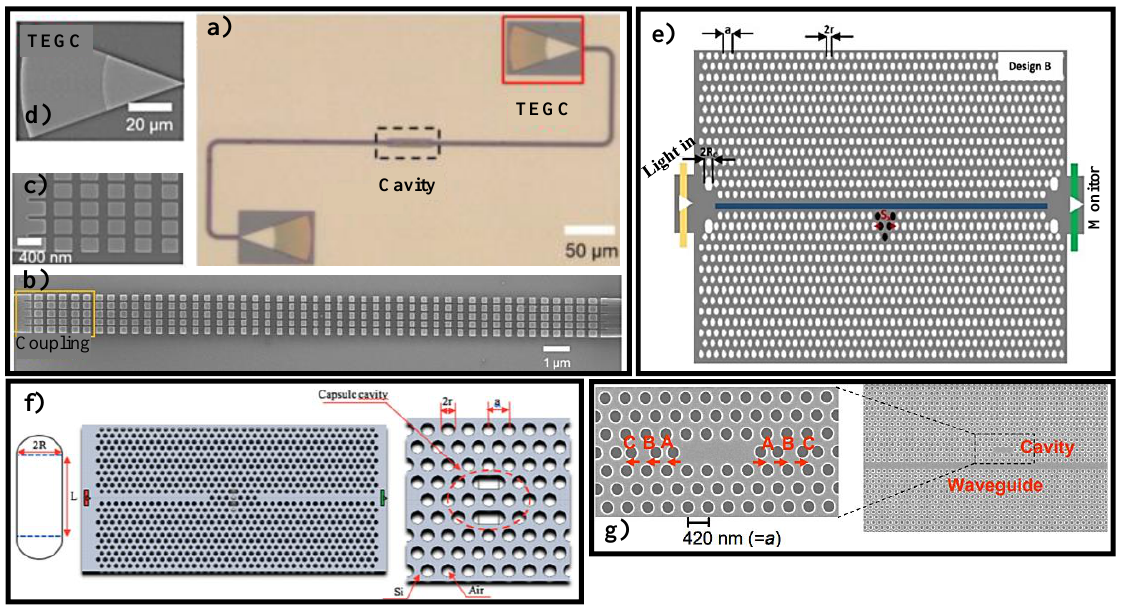
Figure 7. Recently proposed designs of PhC cavity-based sensors, ( a ) optical image of the manufac- tured multi-slot PhC nanobeam cavity [137], ( b , c ) SEM image of the device and the enlarged view of the coupling region connecting the strip or slot WGs [137], ( d ) SEM of the grating coupler [137], ( e ) the redesigned PhC-based slotted-WG coupled-cavity sensor, with the holes (shown in black) forming a resonant cavity for increased S [138], ( f ) PhC capsule-shaped cavity is linked to two WGs in this schematic layout [139], ( g ) the point-defect cavity with displaced air holes A, B, and C are visible in SEM images of the fabricated samples. View of the point-defect cavity magnified (left). The sample from the top. Near the point-defect cavity, a line-defect WG was inserted (right) [140].